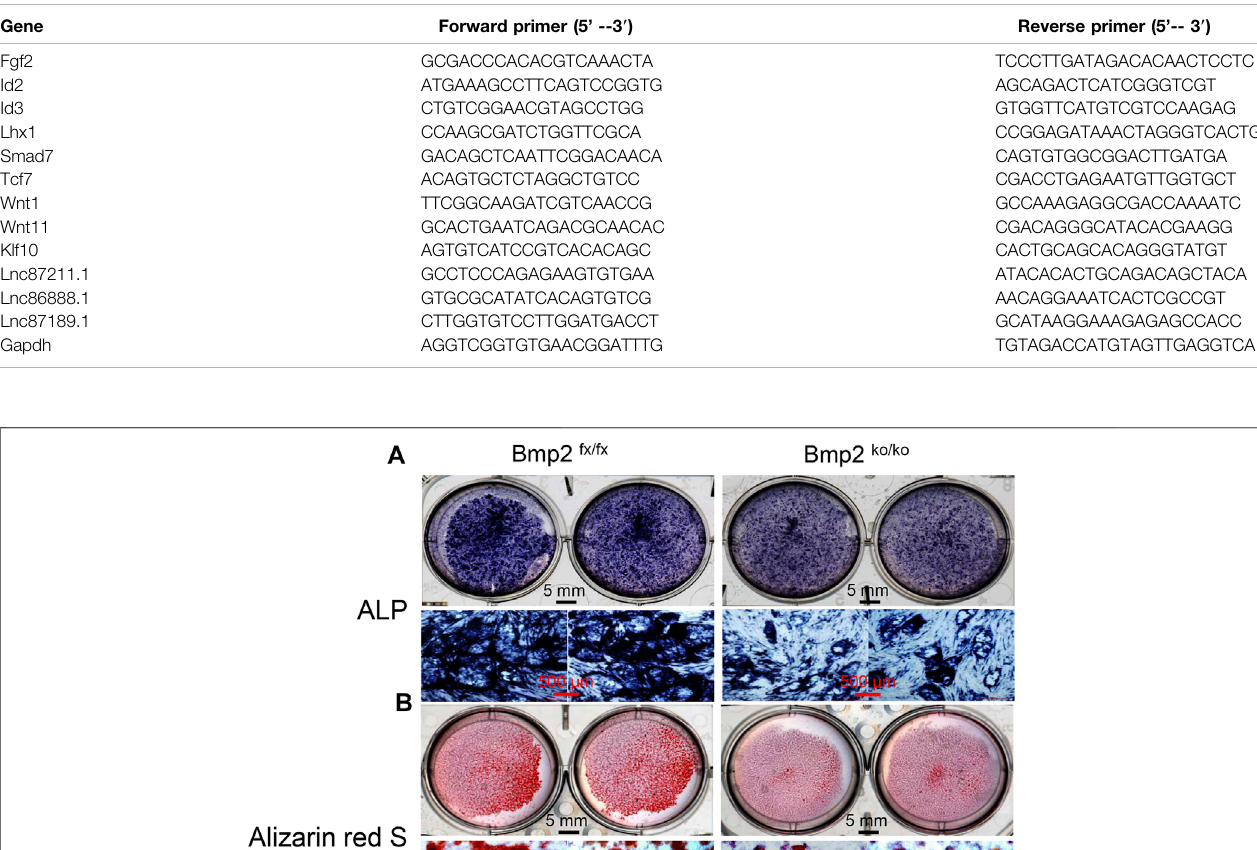
Frontiers in Genetics |